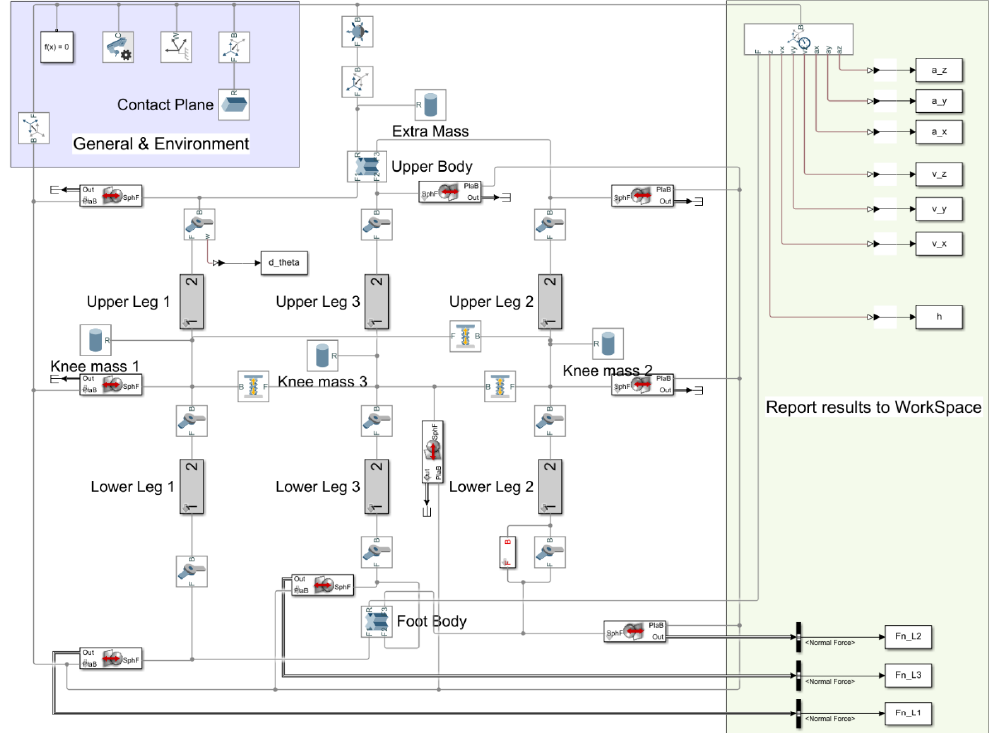
Figure 4. Referred Simulink block diagram.